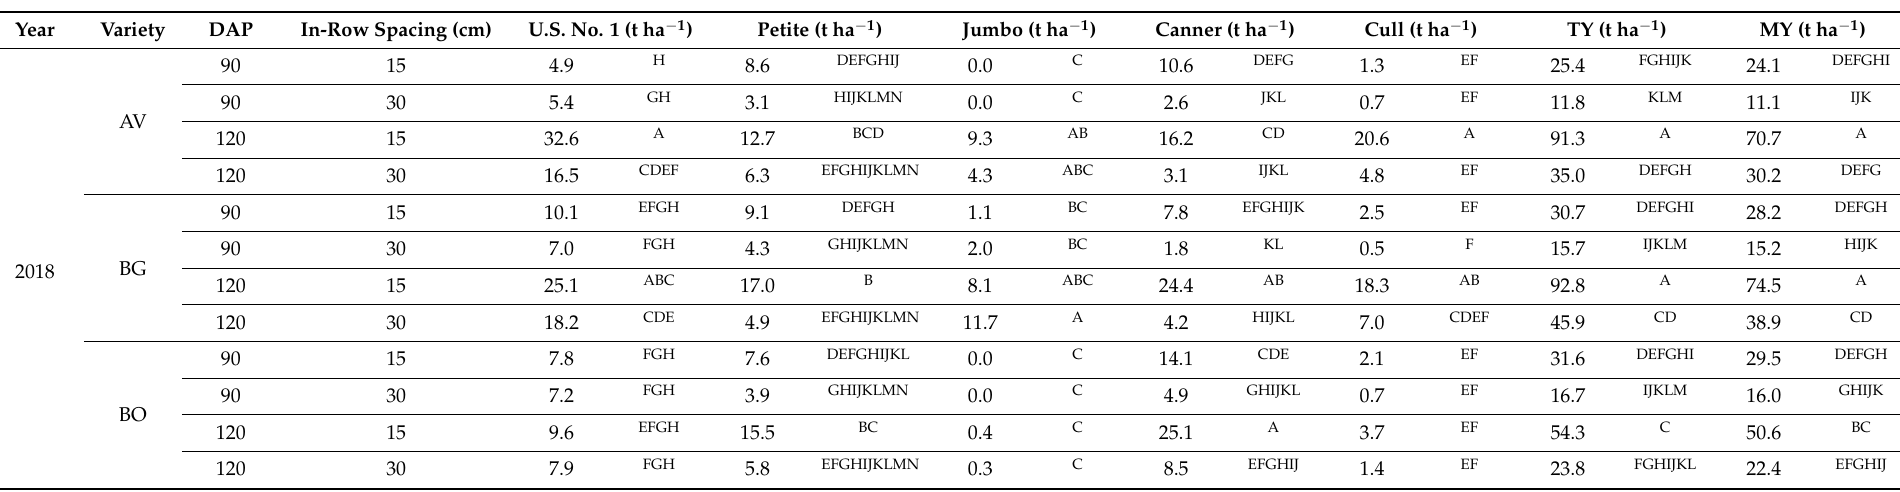
Table 3. Main effects (by variety, days after planting, and in-row spacing) on yields of U.S. No. 1, Petite, Jumbo, Canner, and Cull sweetpotato grades, total and marketable yield for the 2018 (A) and 2019 (B) field